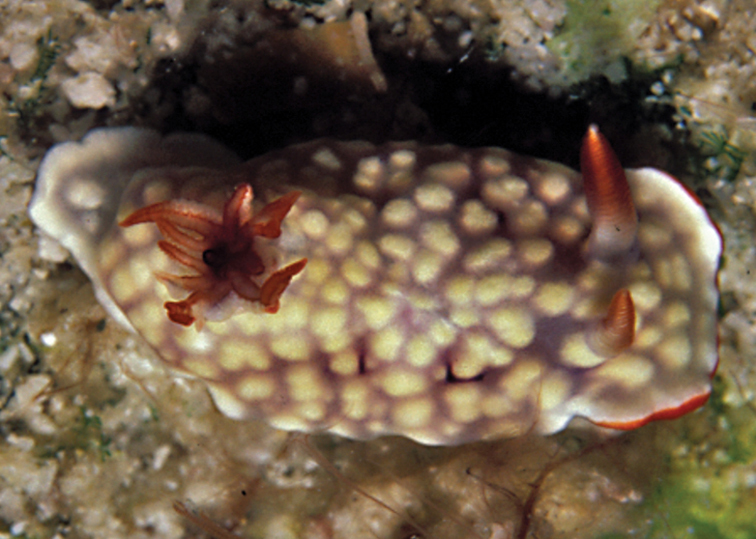
Chromodoris conchyliata, Seychelles, photo: P Kemp (no spcm).